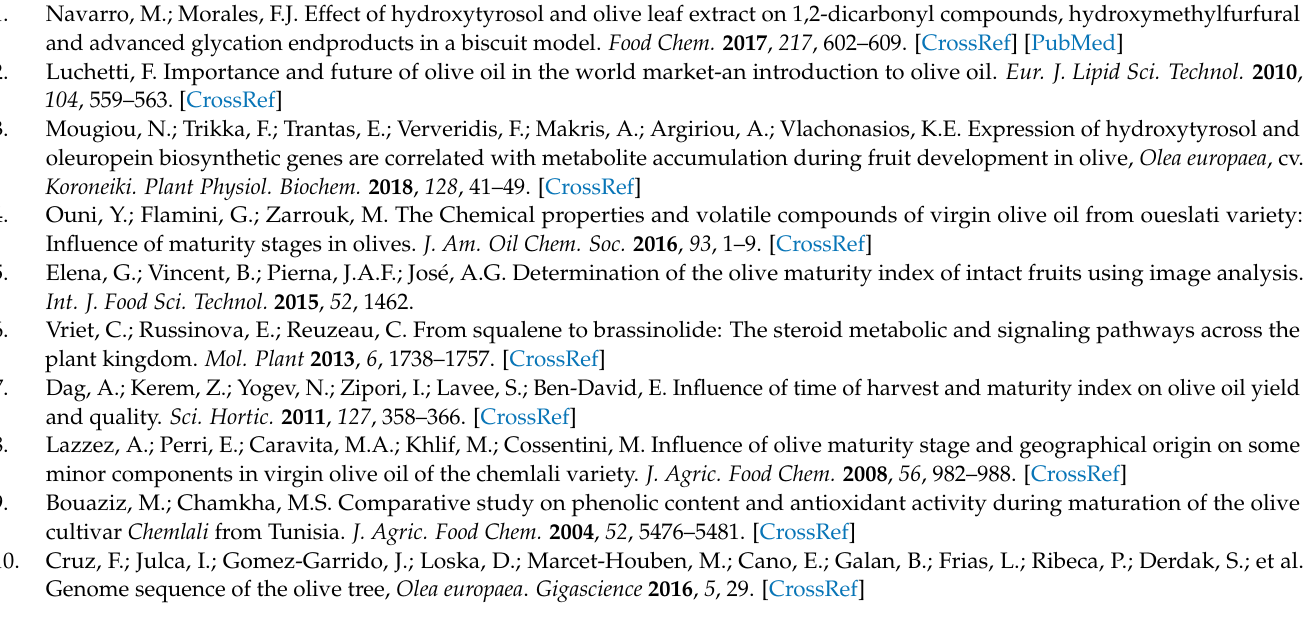
Figure S3: Heat map visualization of ALDH family genes among olive fruits at different maturity stages, Table S1: Data statistics for each sample of RNA-seq, Table S2: Genome mapping of each RNA-seq sample, Table S3: LncRNA target predicting, Table S4: New